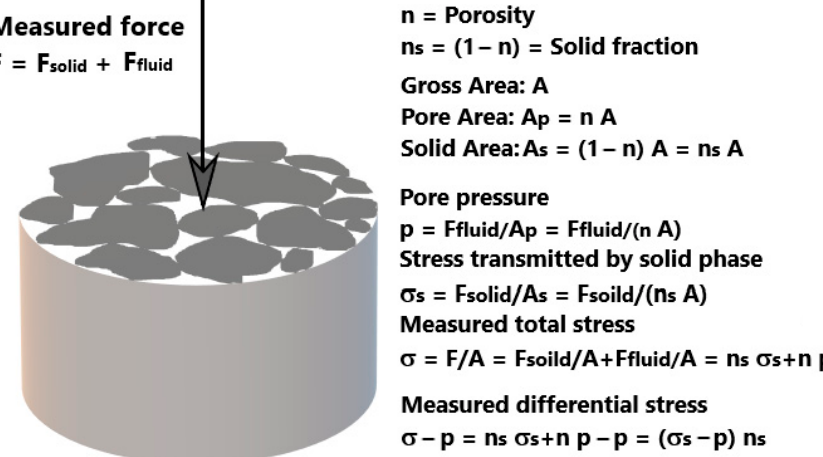
Figure 1. Measured total stress acting over a porous sample.